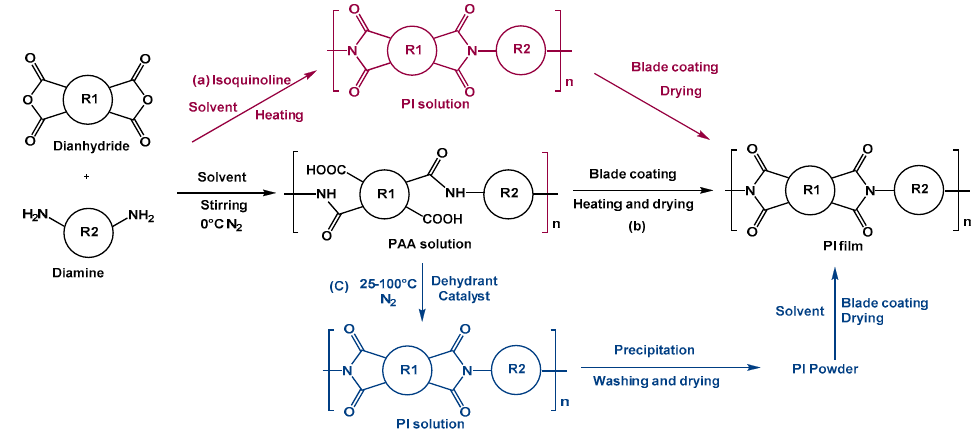
Figure 5. Scheme of PI imidization: ( a ) direct thermal, ( b ) two ‐ step thermal, and ( c ) chemical imidi ‐